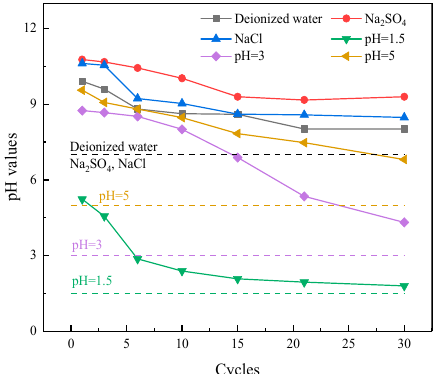
Figure 9. pH values in 30 drying-wetting cycles; the dotted lines indicate the initial values for each solution.